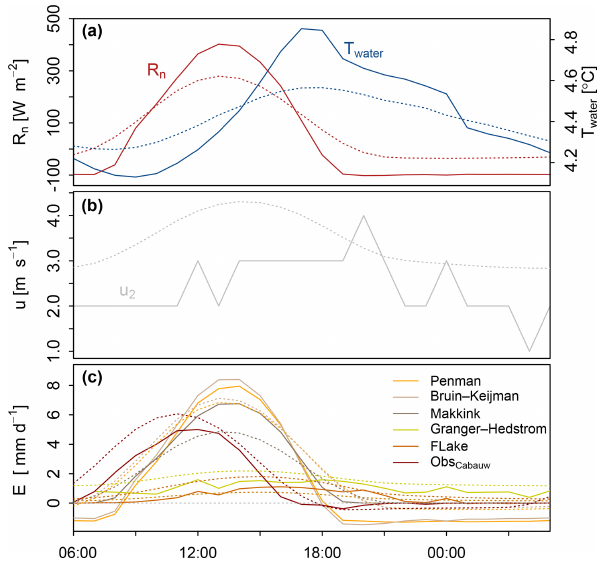
Figure 3. Illustration of the diurnal response of simulated evapora- tion. (a) Diurnal cycle of net radiation and water temperature (b ) of wind speed and (c) of the different evaporation methods. Solid lines represent a sunny day in March 2016, while the dotted lines indi- cate the average diurnal cycle based on the years 1960–2018, and for observed values in Cabauw this is based on the years 1986–1997 and 2001–2018. The dotted line was lowered by 7.5 ◦ C to facilitate comparison of its dynamics to the cycle of the single sunny